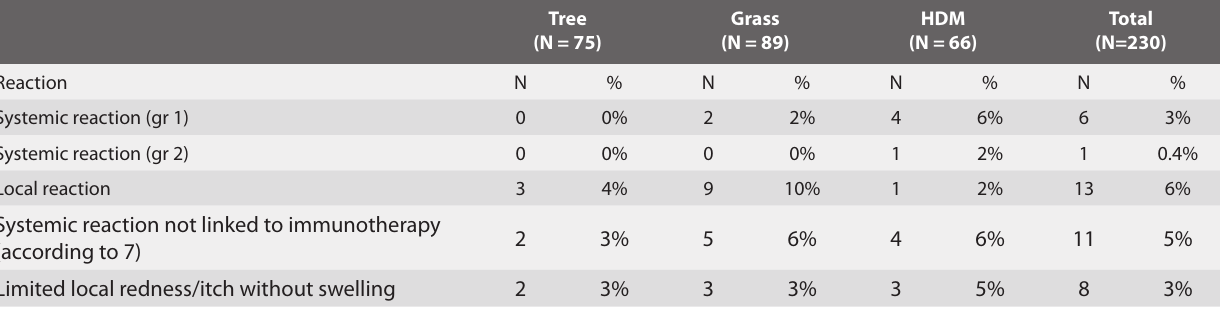
Table 1. Reactions to rush